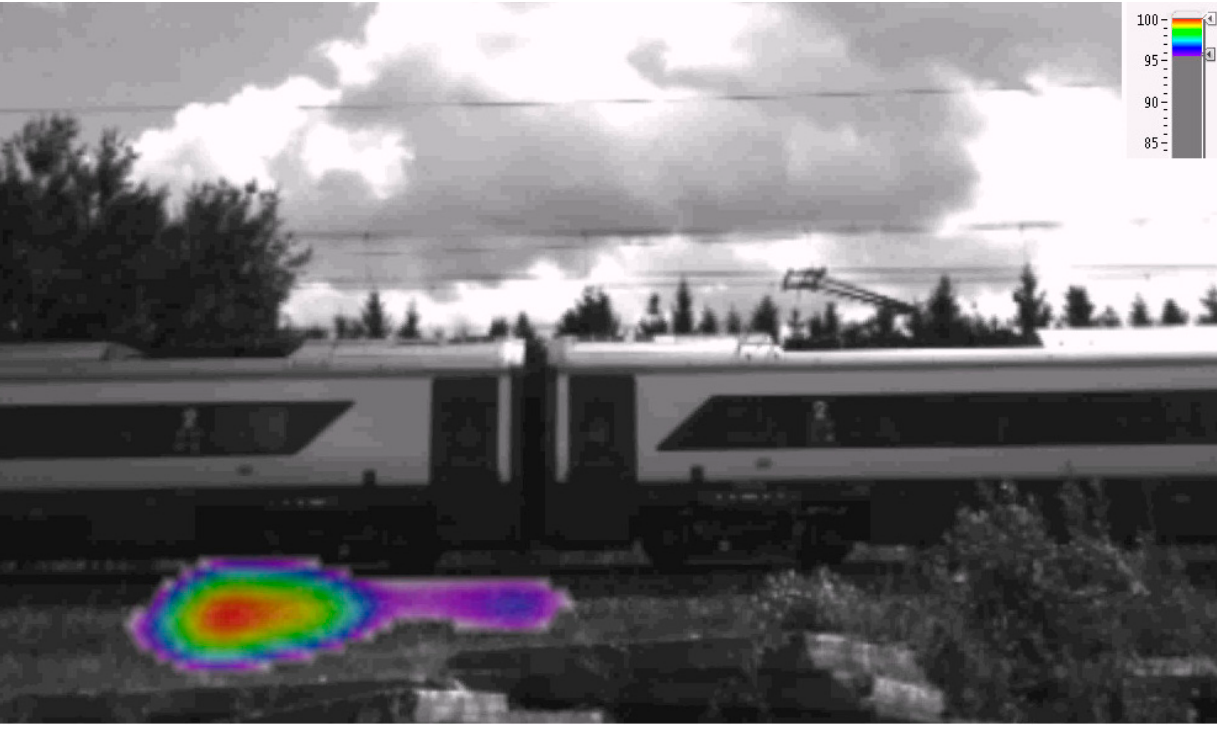
Figure 12. Sound level distribution within a frequency range of 2000–3000 Hz—straight section .